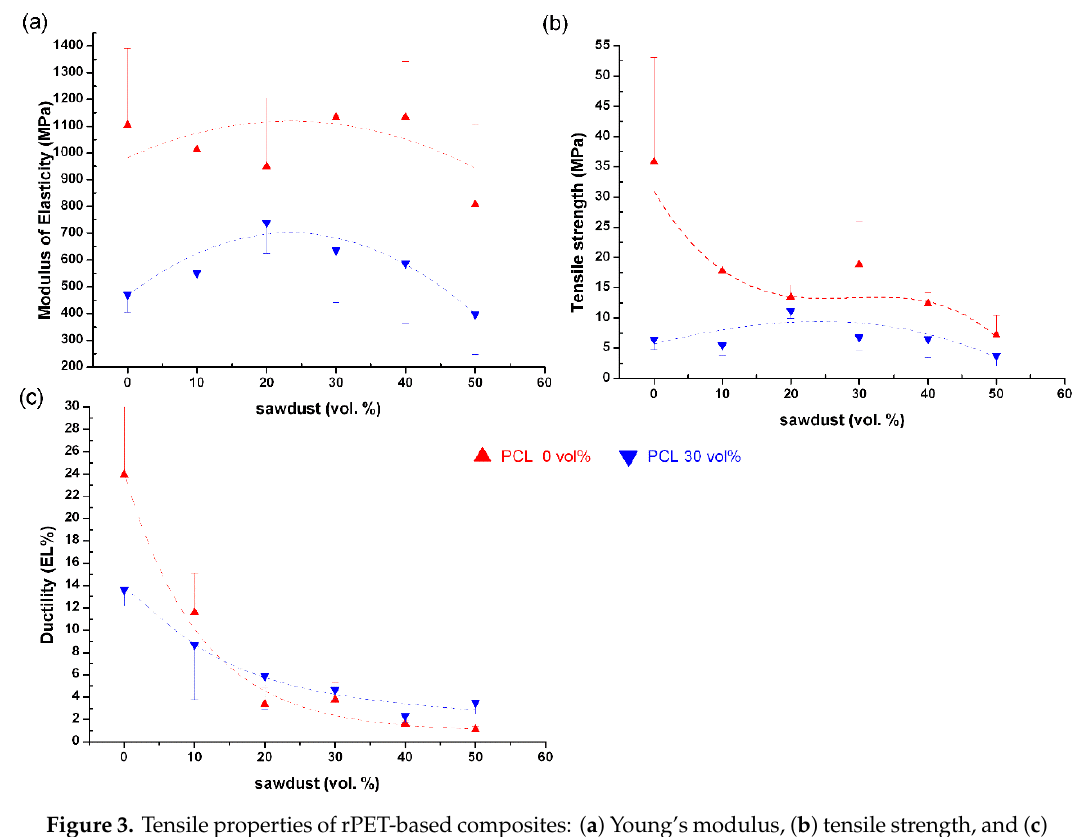
Figure 3. Tensile properties of rPET-based composites: ( a ) Young’s modulus, ( b ) tensile strength, and ( c ) ductility as function of PCL and SD contents. Dotted lines represent polynomial ( a , b ) and exponential ( c ) fits. Error bars are shown in one direction only.